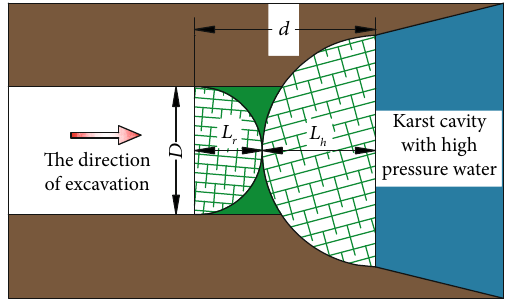
Figure 14: Schematic diagram of the minimum safe thickness for a rock